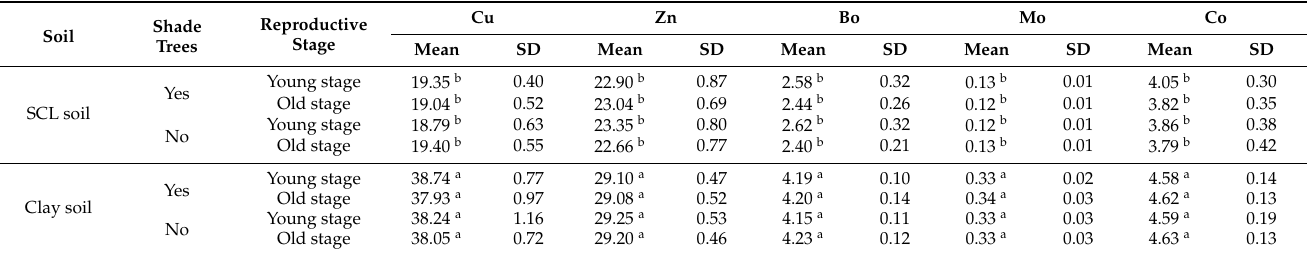
Table 3. The concentrations (mg kg − 1 ) of selected micronutrients in the examined soils. Within the mean column, data attached with the same letter were not significantly different from each other. Details of the main and interaction effects of three experimental factors were shown in Supplementary Table S3. SCL = sandy clay loam; SD = standard